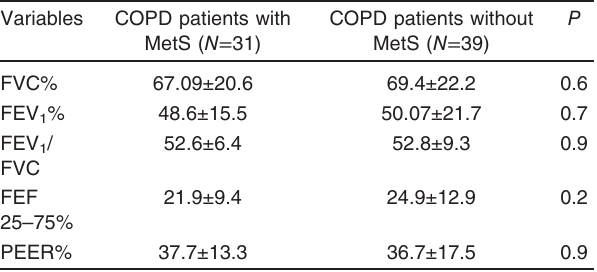
Table 3 Results of spirometry between patients with chronic obstructive pulmonary disease with and without